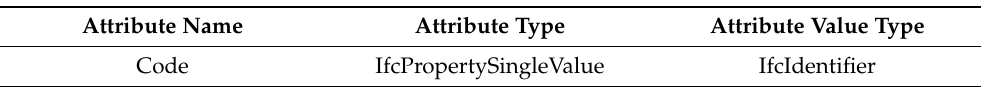
Table 4. Code attribute